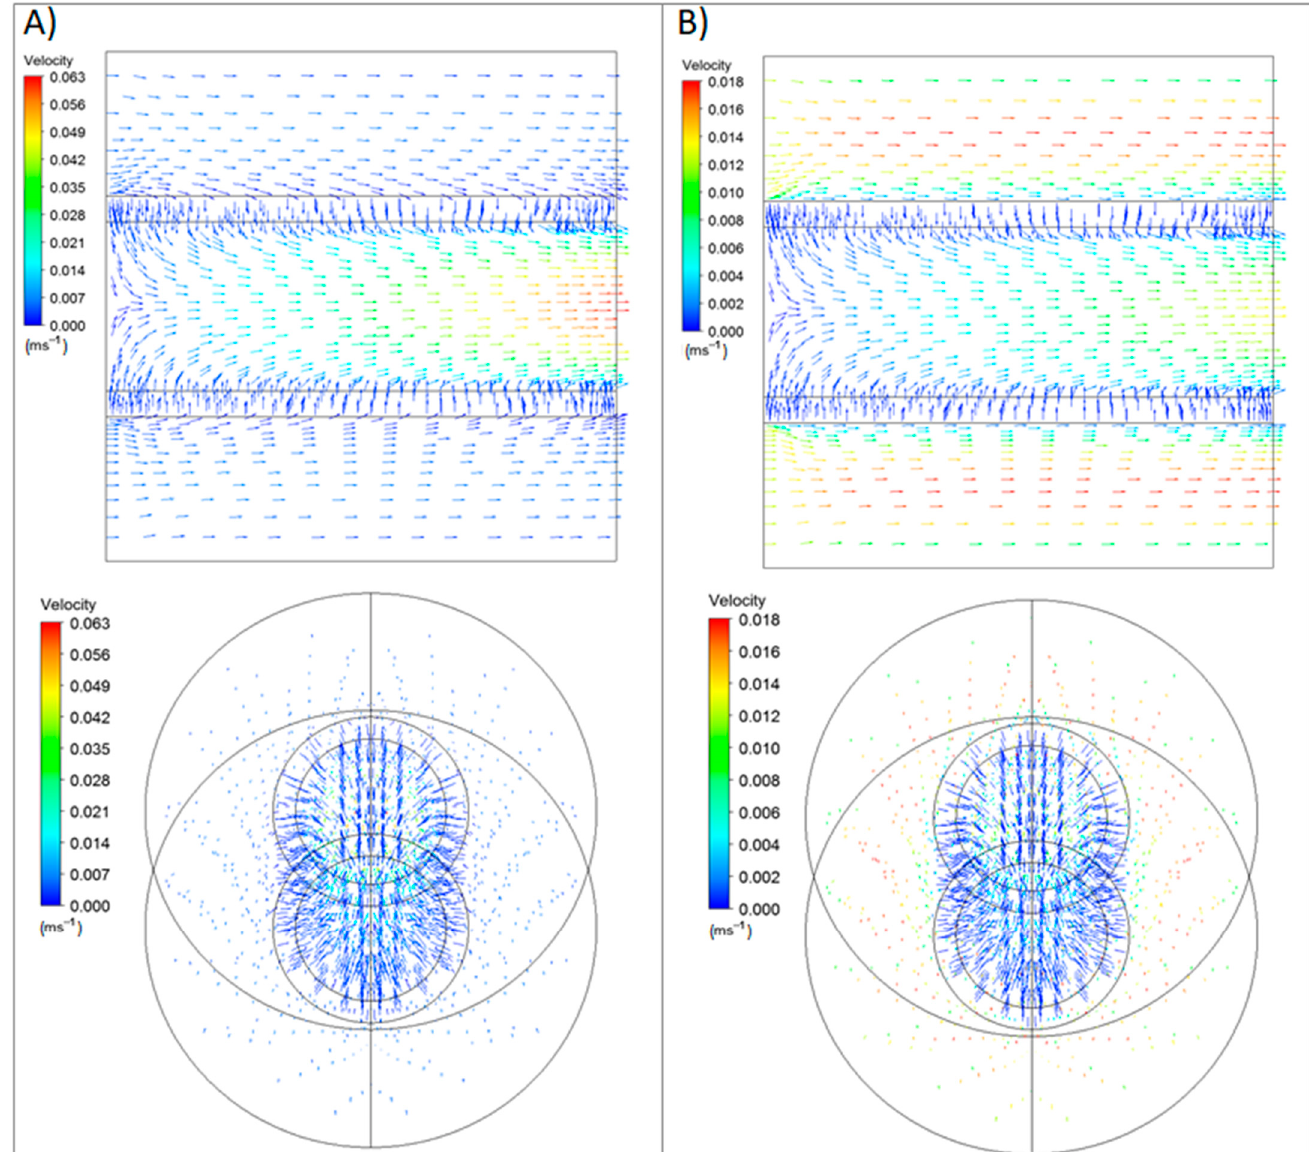
Figure 8. Velocity vectors for the out–in configuration at a constant temperature ( T = 375 °C) and feed pressure ( Δ P = 2 bar), but two different H 2 molar fraction: ( A ) 0.9 and ( B ) 0.5.